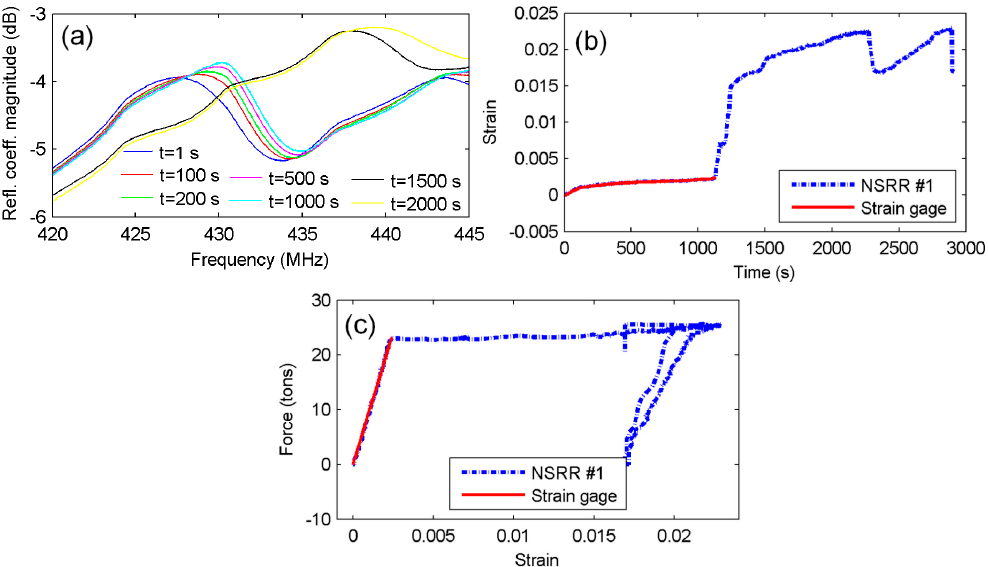
Figure 9. Plastic deformation region measurements: ( a ) NSRR #1 resonance peaks at several time instants; ( b ) strain obtained by NSRR #1, plotted versus time and compared to the data from the strain gages until the strain gages break down; and ( c ) the force–strain curve plotted with both NSRR #1 and strain gage data.